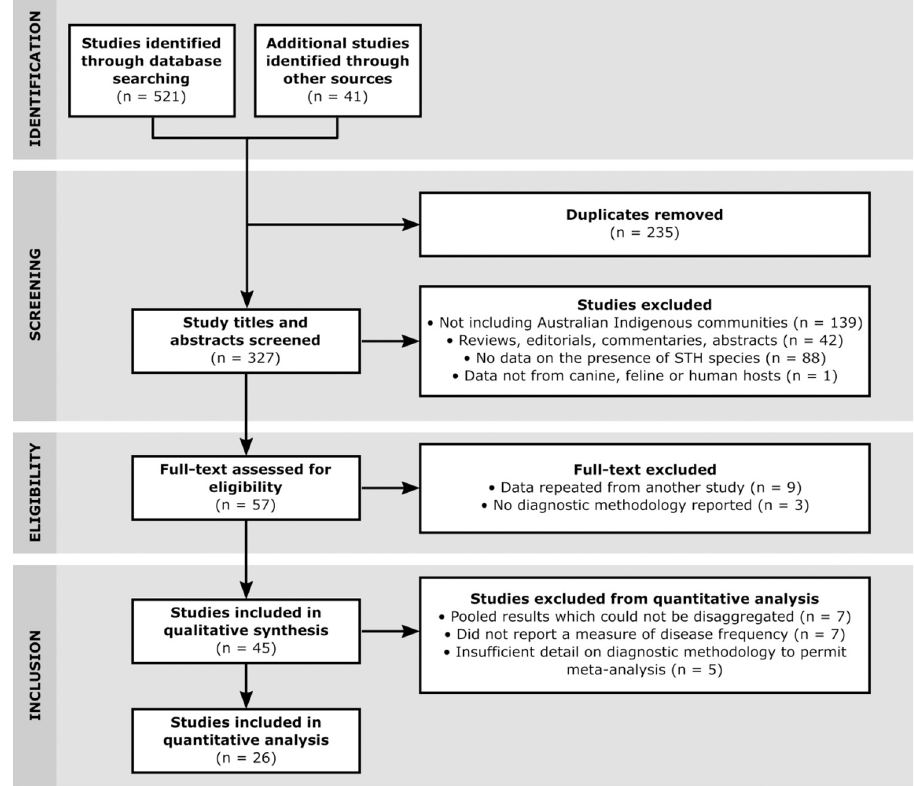
Fig 1. PRISMA flow diagram of the search, screening for eligibility and inclusion in qualitative and quantitative synthesis.